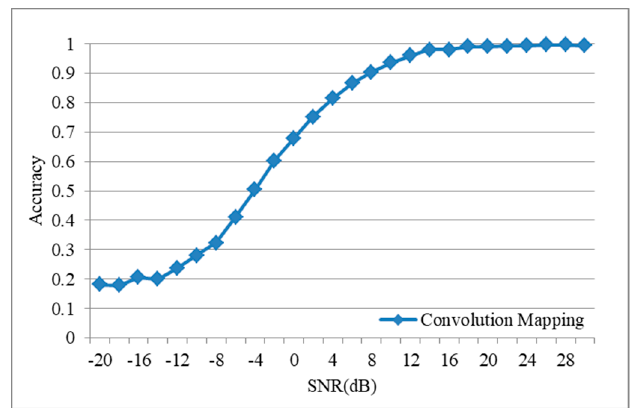
Figure 10. Classification accuracy of each SNR of dataset OFDMSig.